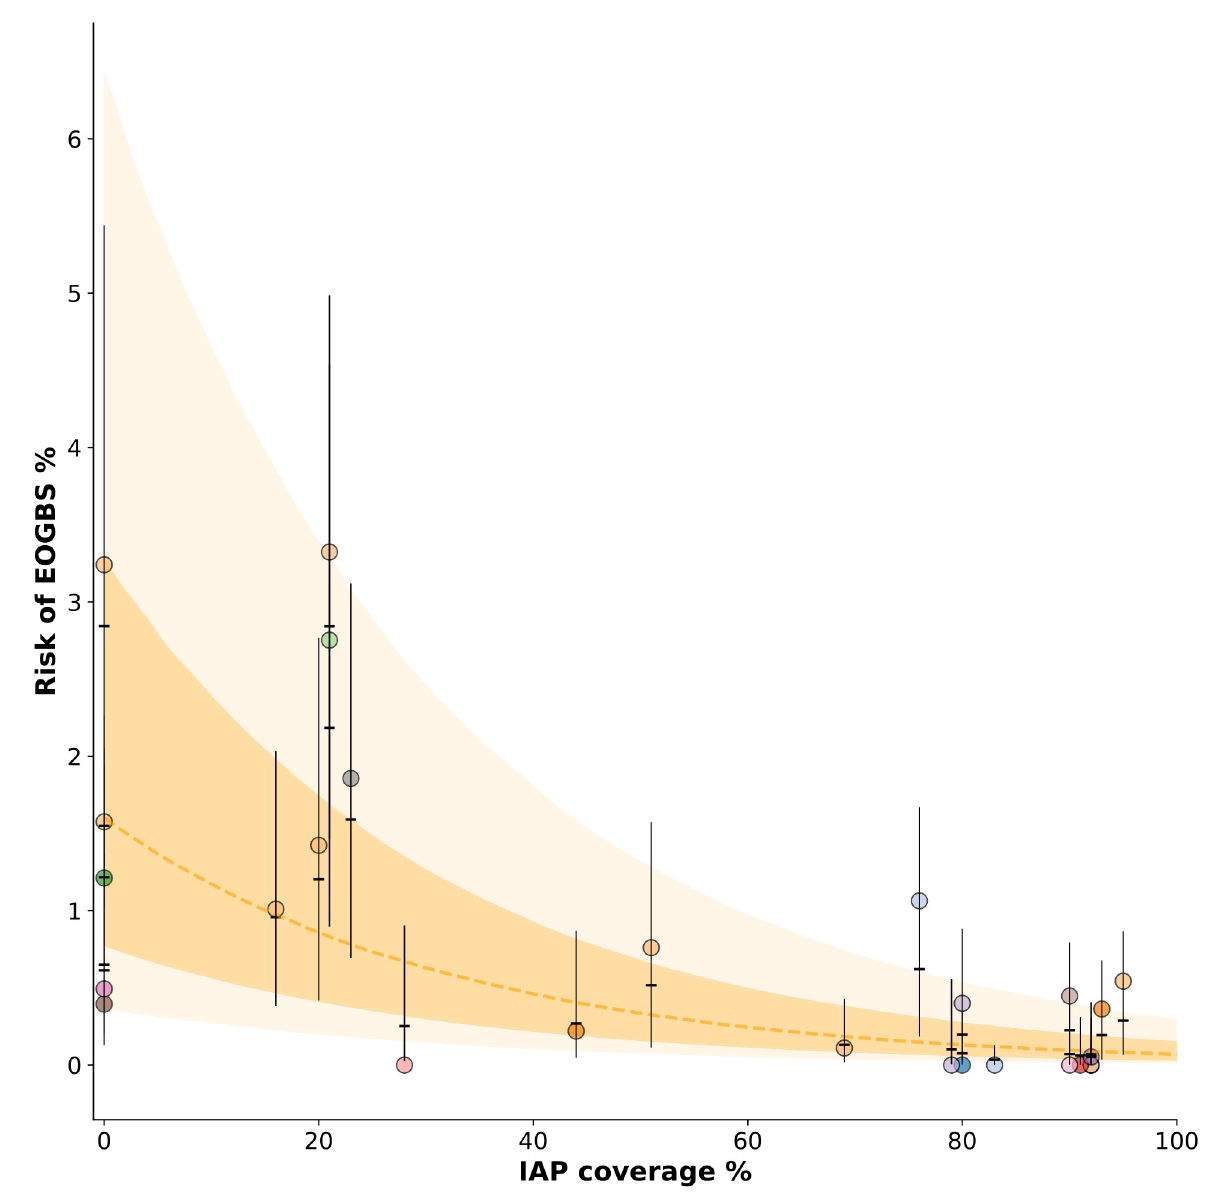
Fig 4. Risk of early-onset invasive GBS disease (EOGBS, y-axis) by intrapartum antibiotic coverage (x-axis). For this figure, the model described in the subsection Early-onset invasive GBS disease in babies born to GBS-colonized mothers was used. The shaded area represents the 10–90% interval of the risk of early-onset iGBS disease in a new study; the distribution was generated by assuming the intercept for a new study i follows the distribution a ð m Þ � Normal ð a ð m Þ ; s ð m Þ 2 Þ , which uses estimates of α g and σ eo at each iteration m . The darker orange shade represents the interquartile range of the i (cid:0) new g eo same distribution and the dashed line, the median. Of note, this does not incorporate the component of the predictive probability linked to sampling uncertainty; it only incorporates the component related to estimation uncertainty. Each circle represents a different study included in the analysis, with circles of similar colour corresponding to studies performed in the same country. Posterior medians and 95% intervals of the risk in these studies, i.e. r i for studies in the analysis dataset, are shown as black lines.